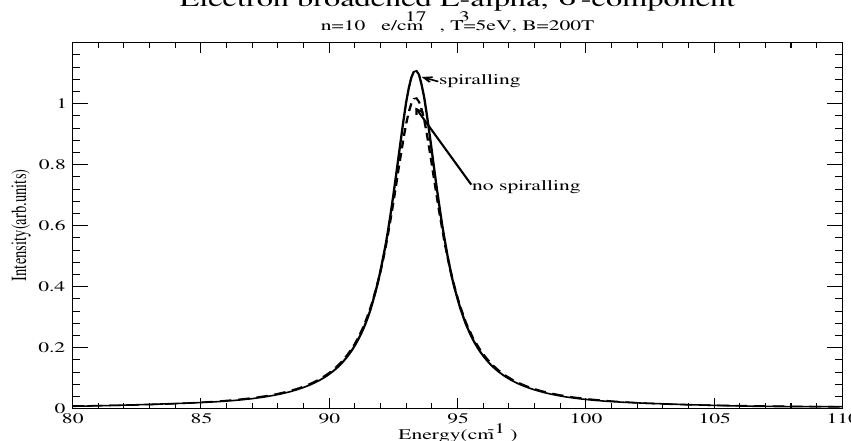
Figure 6. Line profile of the Ly − α σ - compoment with and without account of spiralling for n = 10 17 e/cm 3 , T = 5 eV and B = 200 T. The horizontal scale represents energy difference from the unperturbed line center.